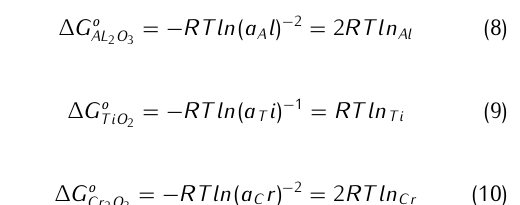
Table 2. The minimum activities of Al, Ti and Cr to form Al